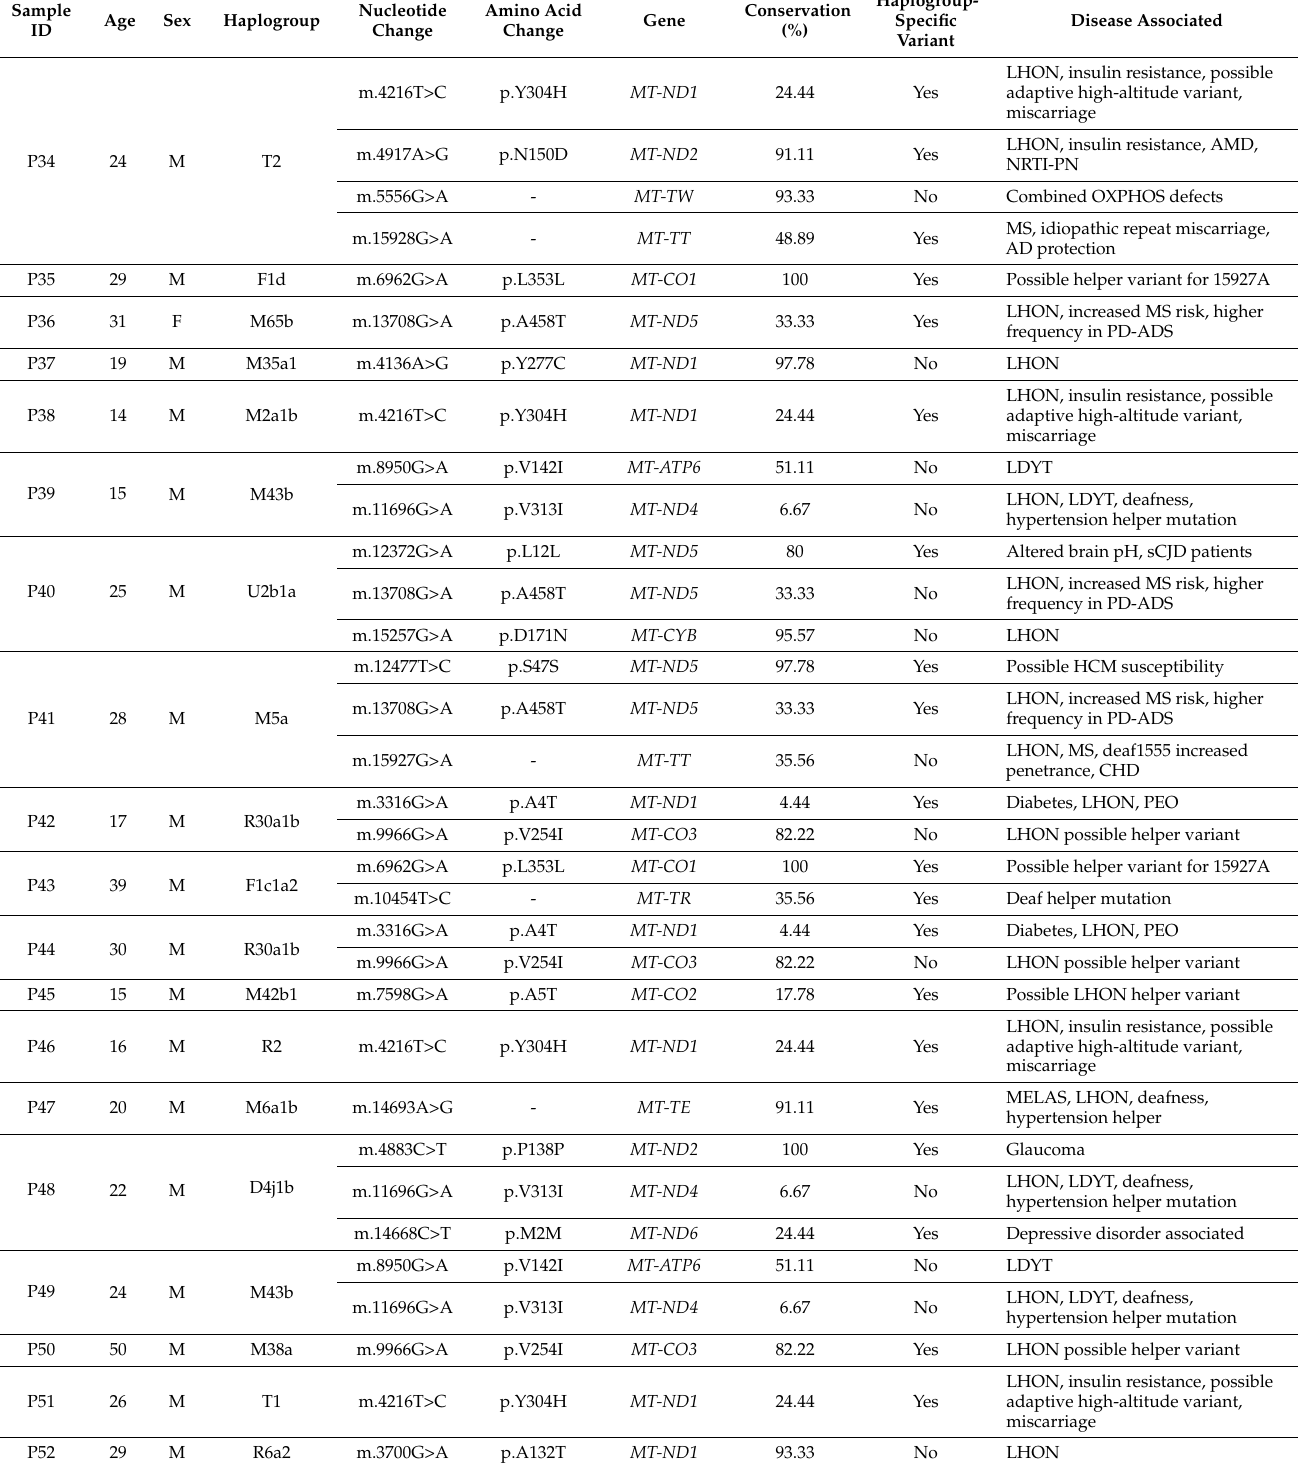
Table 4. List of variants identified and haplogroups in patients with secondary LHON